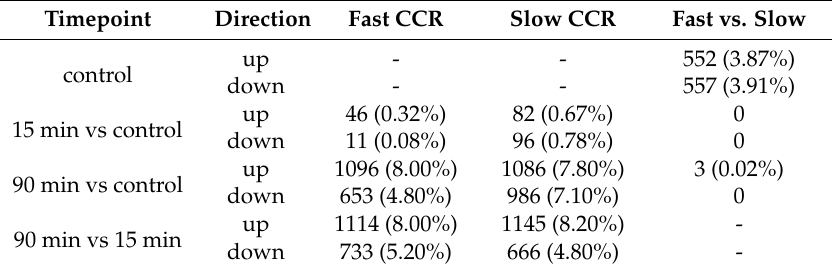
Table 1. Differentially expressed genes in D. ananassae